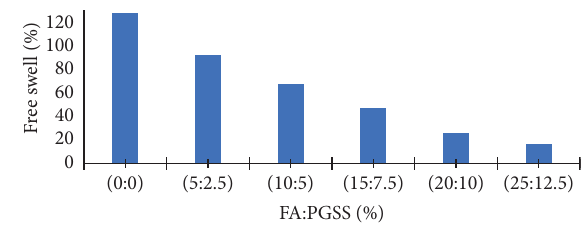
Figure 3: Swell property of expansive soil blended with FA and